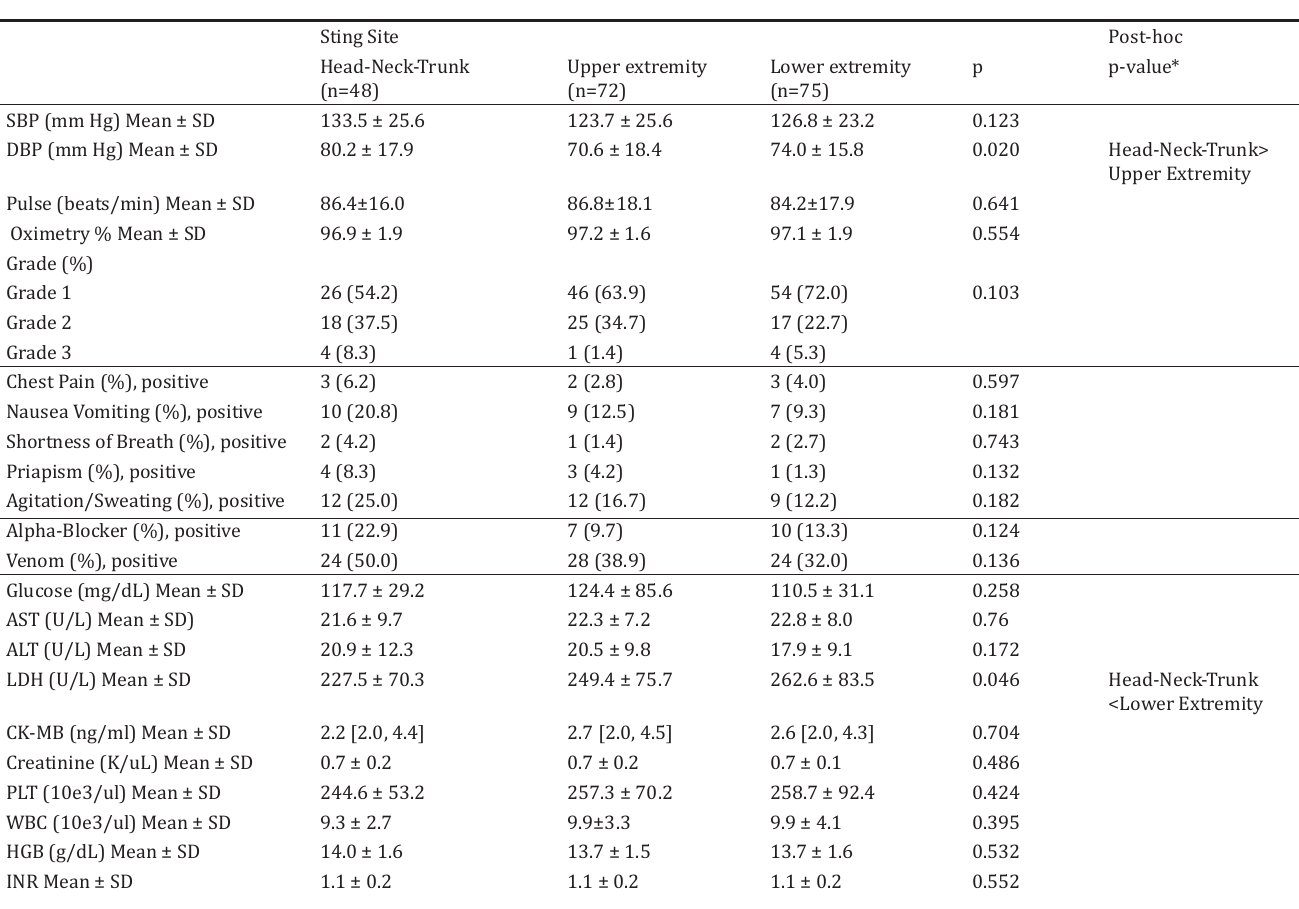
Comparison of some of the vital parameters, emergent complications, administered treatments, and laboratory parameters by the site of the